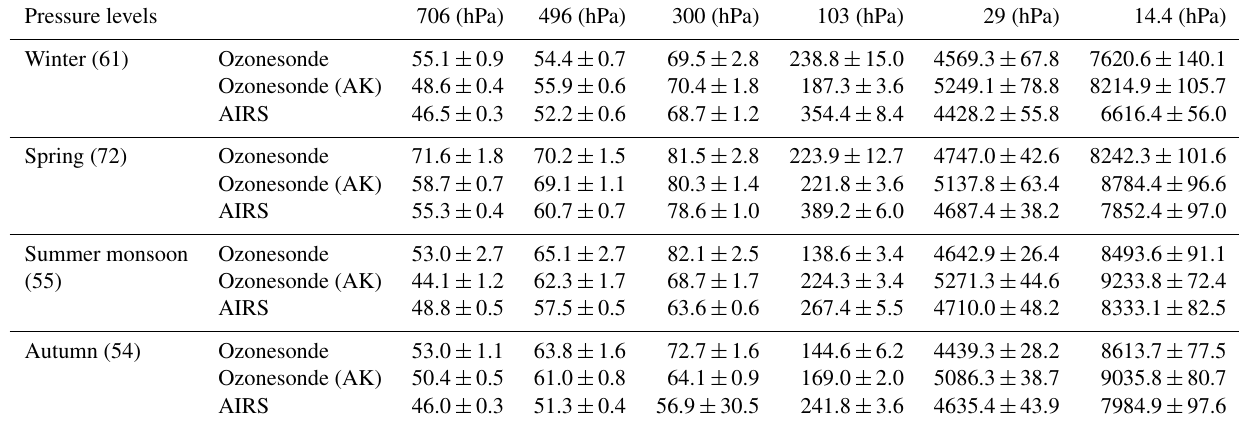
Table 1. The mean values and corresponding standard errors in ozone mixing ratio (ppbv) from ozonesonde, ozonesonde (AK), and AIRS over Nainital at six pressure levels and during winter, spring, summer monsoon, and autumn are given. The number of ozonesonde flights during four seasons is mentioned in the